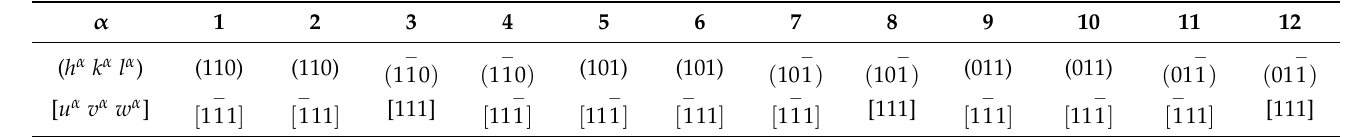
Table 2. Twelve equivalent slip factors of BCC lattice at room